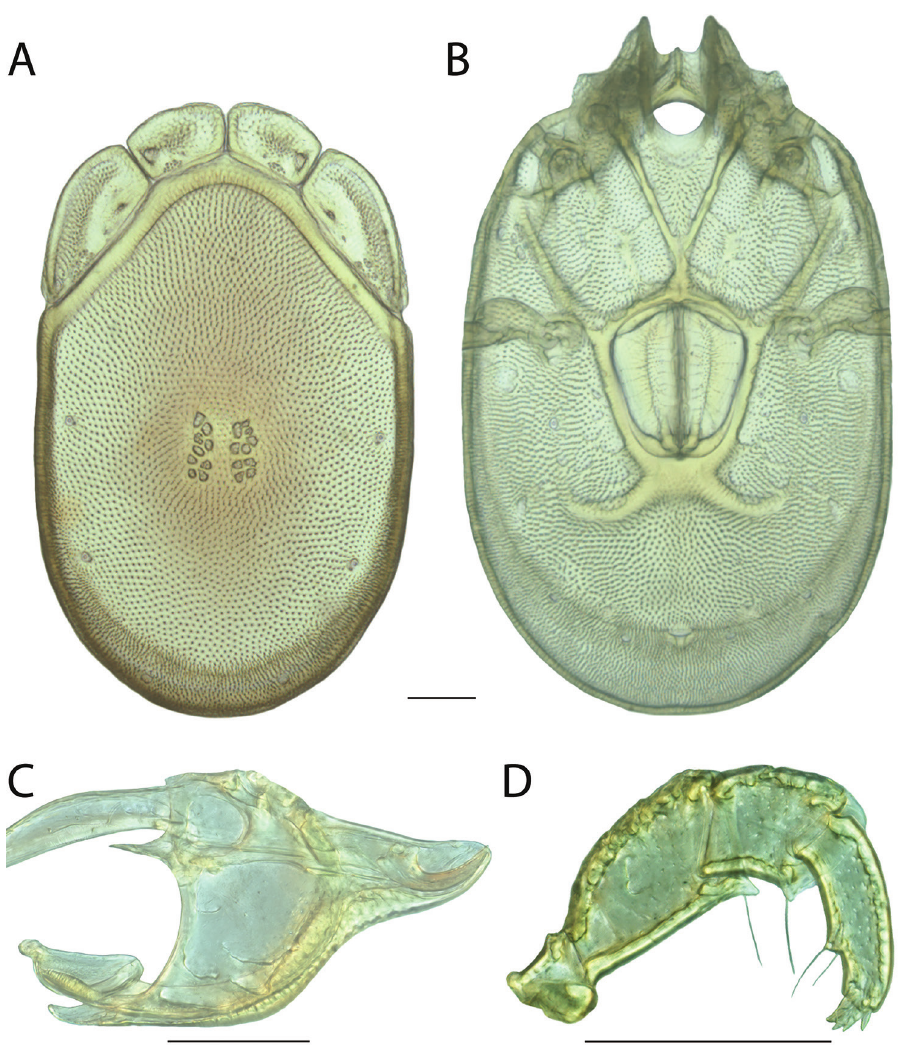
Figure 65. Torrenticola ellipsoidalis female: A dorsal plates B venter (legs removed) C subcapitulum D pedipalp (setae not accurately depicted). Scale = 100